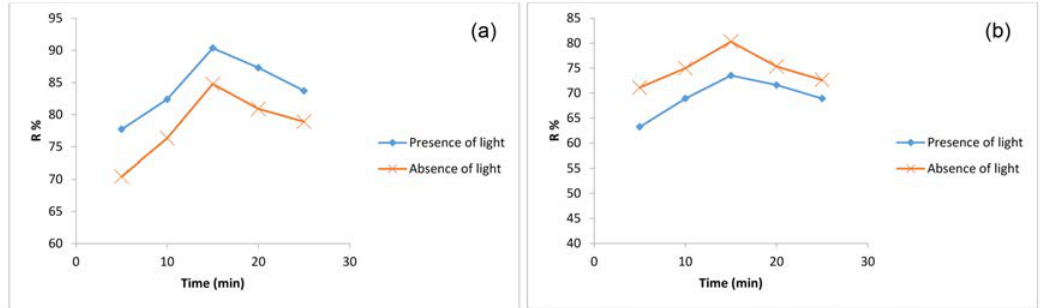
Fig. 8. The effect of contact time for removal of lead ions in the presence and absence of light by nanocomposites (a) Nd-TiO2/ bentonite (b) Ce-TiO2/bentonite